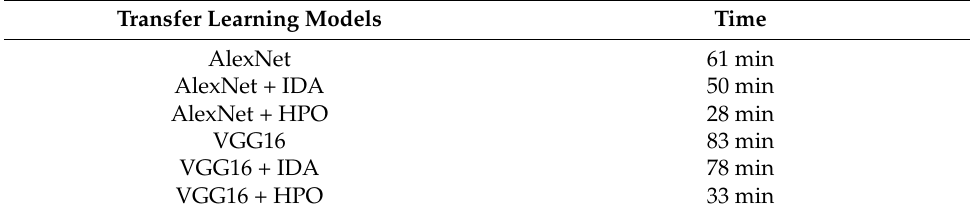
Table 10. Transfer learning models with execution time.